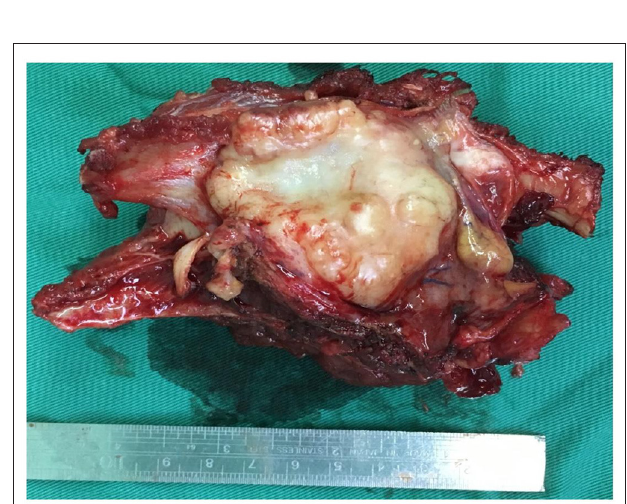
FIGURE 2 | Gross photograph of the sectioned specimens from revealed a gray-yellow gray-brown foliated nodular tumor.